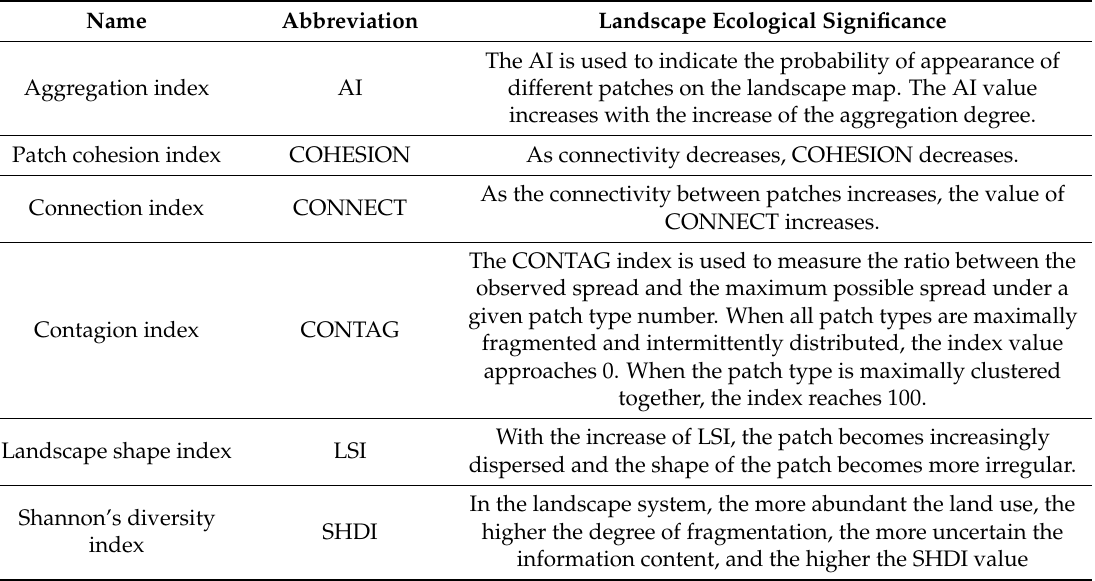
Table 1. The landscape ecological significance of each landscape pattern